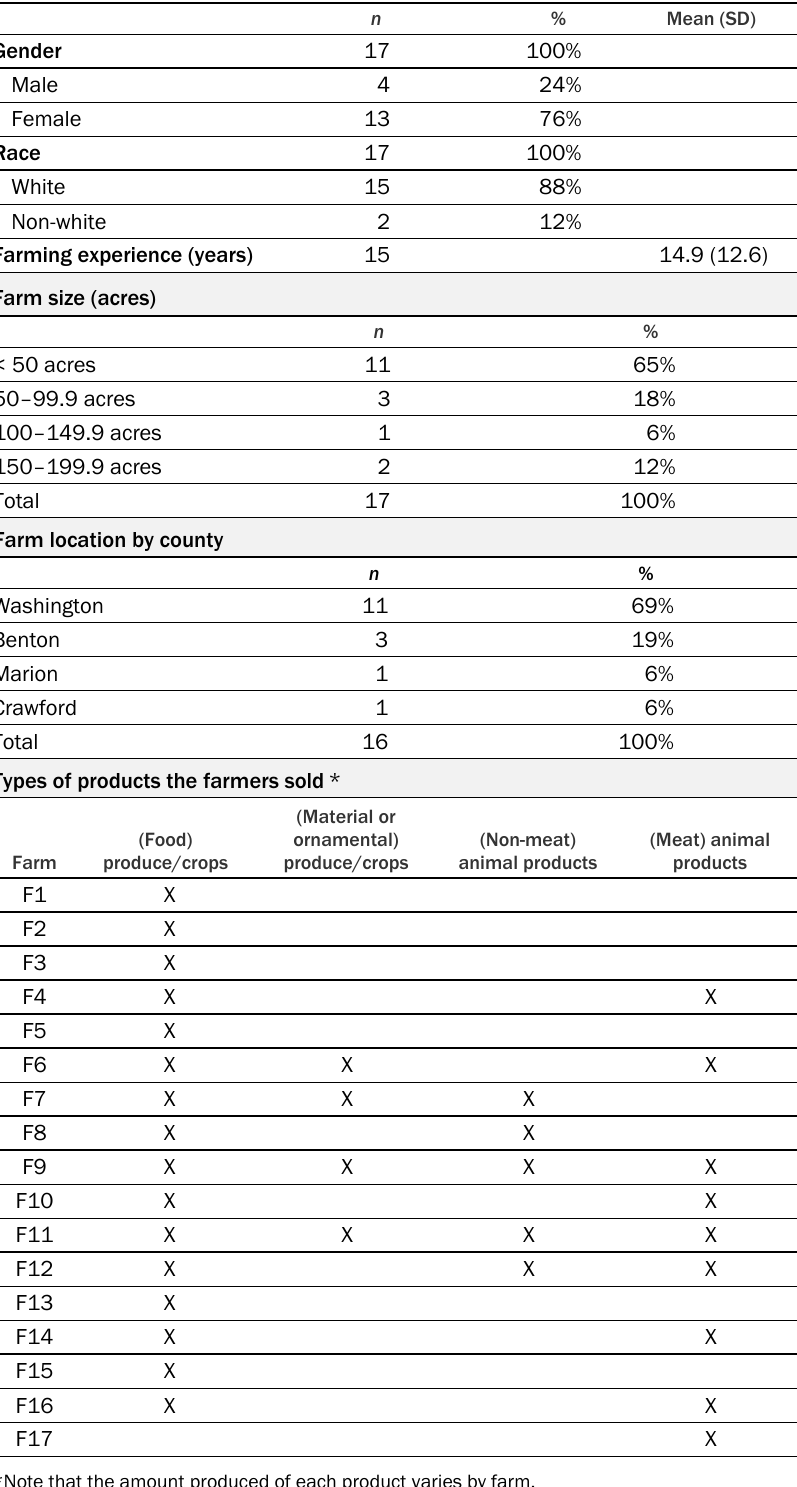
Table 2. Characteristics of Surveyed Farmers and